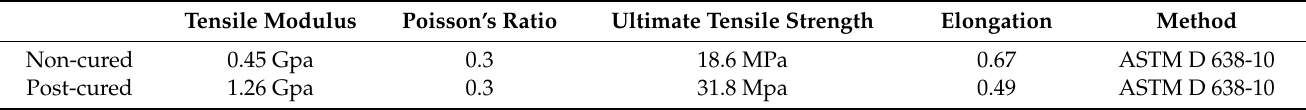
Table 1. Mechanical property parameters of the